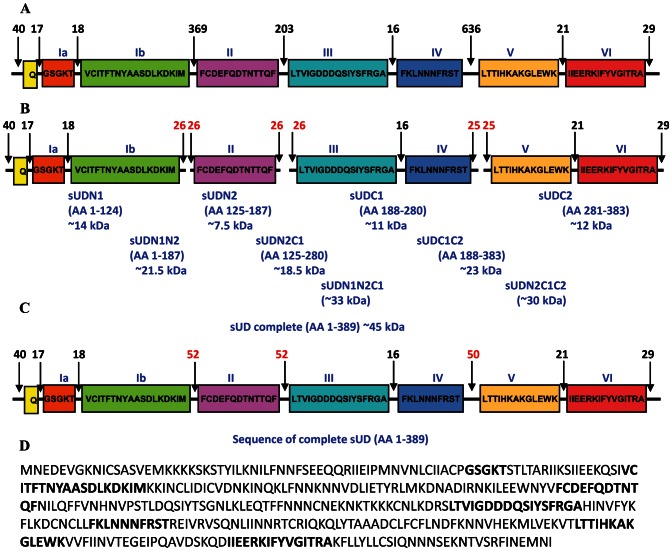
Sequence and domain organization of UvrD.A. The detailed domain organization of P. falciparum UvrD helicase. The conserved sequences of each domain are written inside the boxes. The text in blue refers to the names of various conserved domains and the numbers refer to the amino acids separating the various domains and the length of N- and C-terminal extensions. This figure is not drawn to scale. B. The strategy used for constructing the various fragments. The numbers in red refer to the reduced number of amino acids in between the domains. The details of all the fragments are listed. C. Domain organization of full length sUD. D. Complete amino acid sequence of synthetic UvrD (sUD). The sequence of conserved domains is written in bold letters. See also Figures S1 and S2.